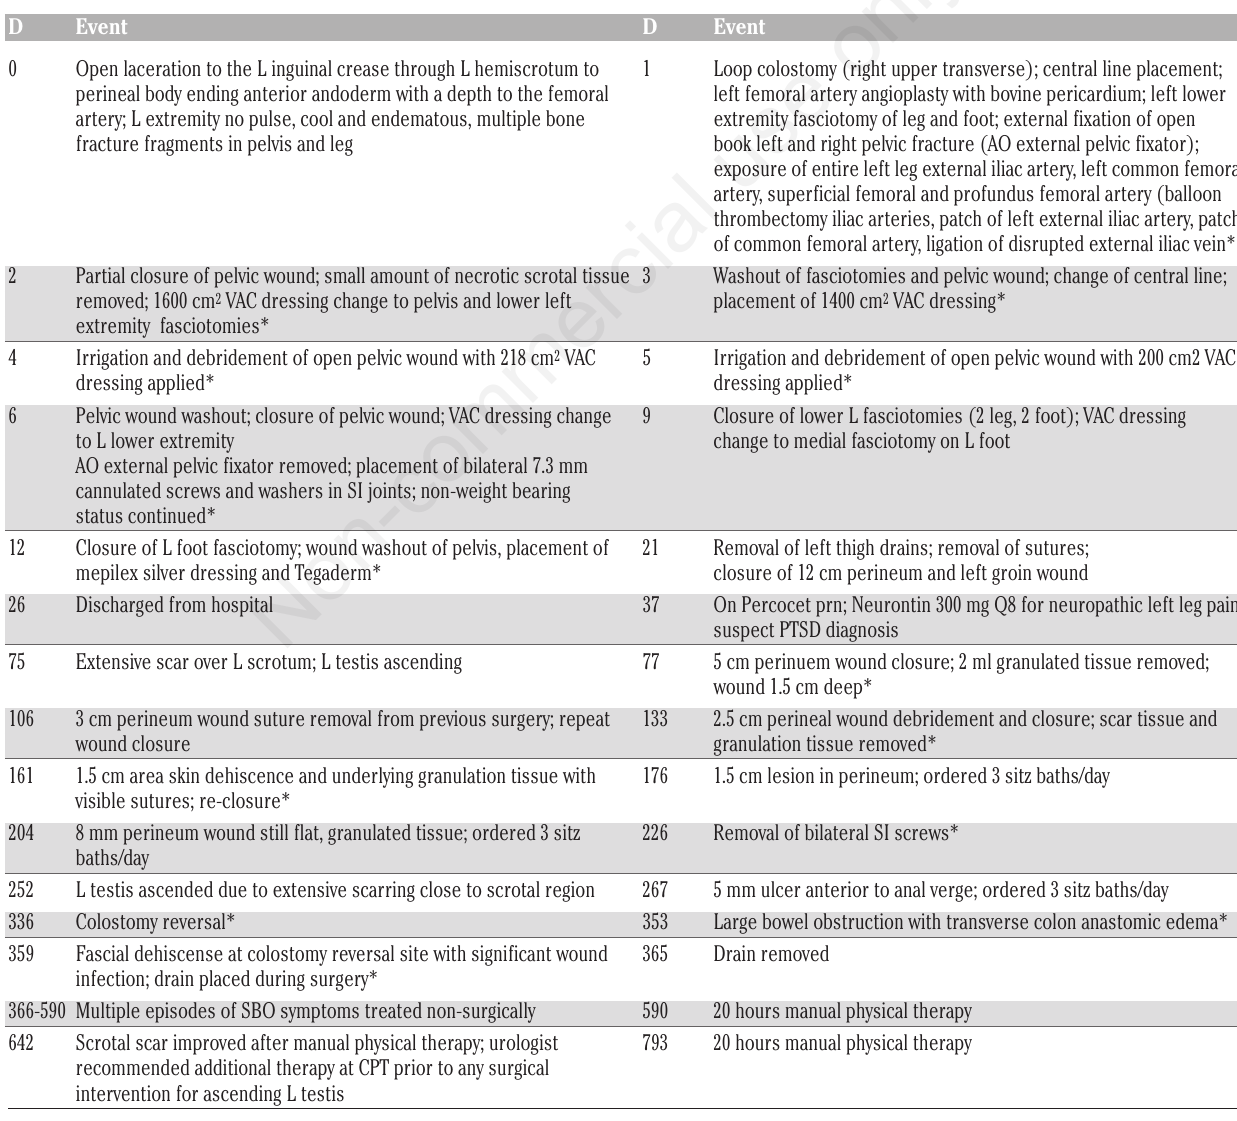
Table 1. Medical treatment timeline beginning at the initial trauma caused by the collision of a motor vehicle with the patient as a